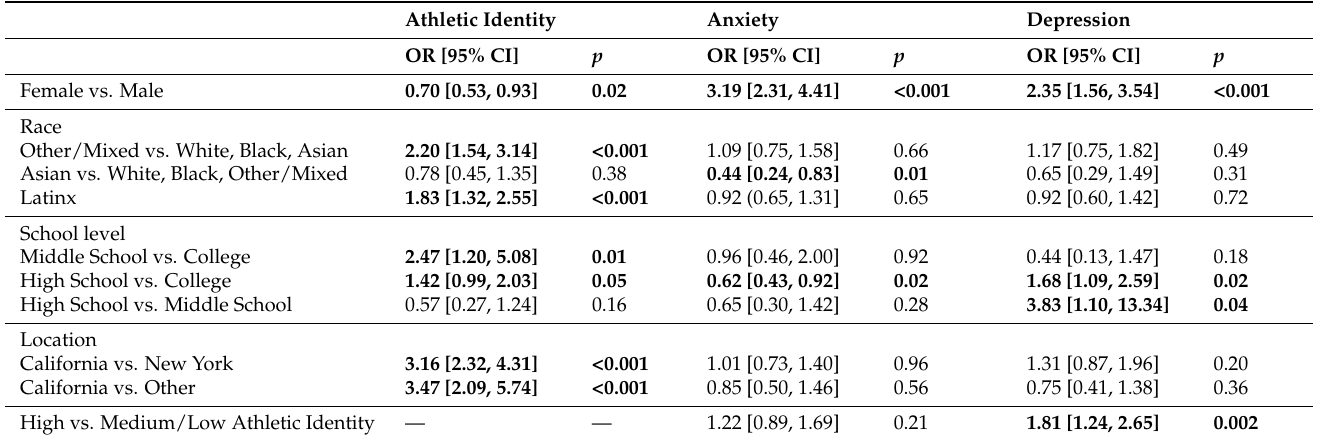
Table 3. Associations between athletic identity, symptoms of anxiety, and symptoms of depression and demographic